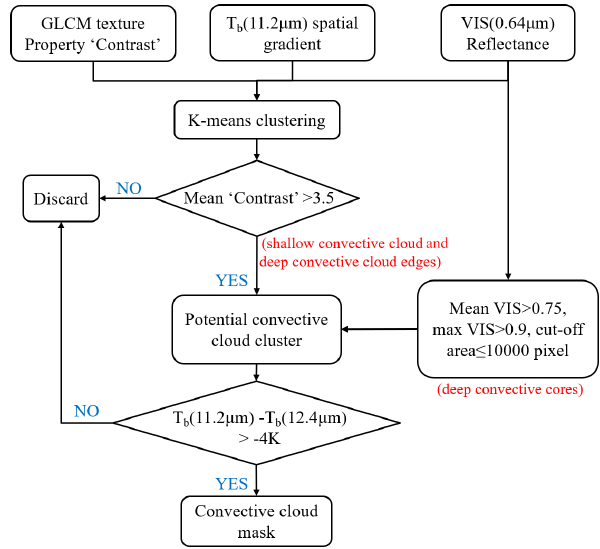
Figure 2. Flowchart of the convective cloud identification